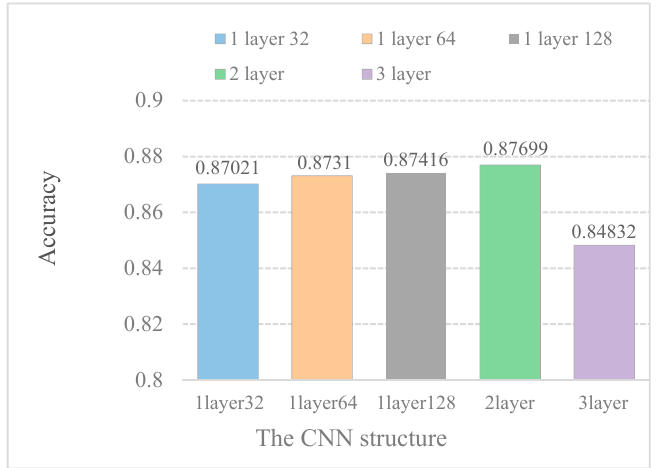
Figure 4. Accuracy of different CNN structure models in the SubMitoPred dataset.